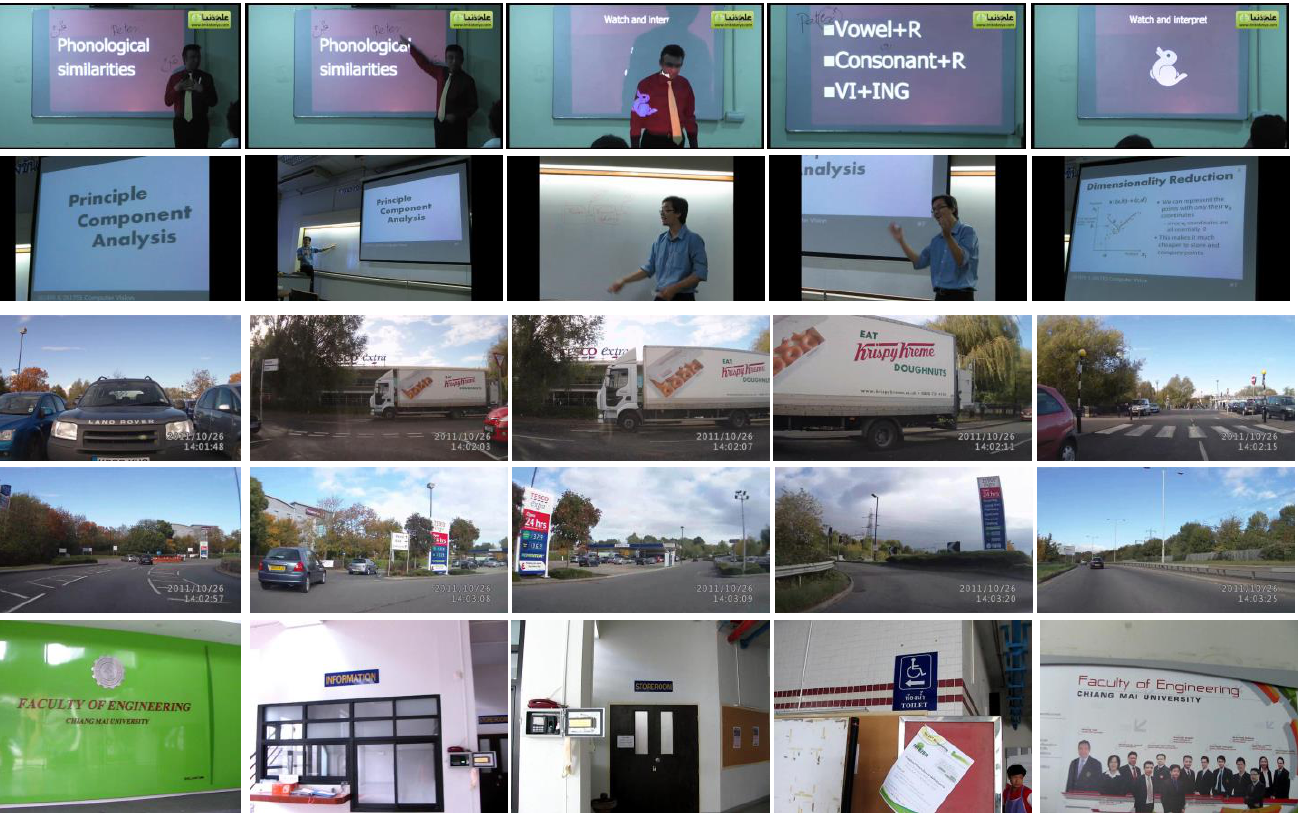
Figure 5. Screenshots of five videos used in the